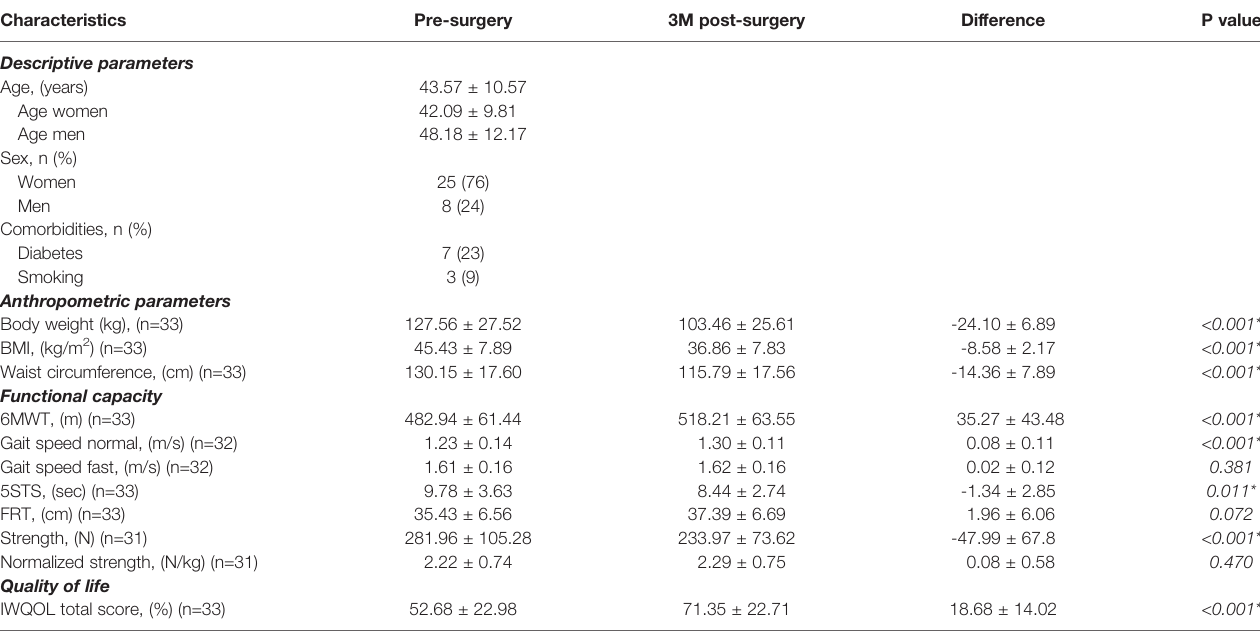
TABLE 2 | Changes in anthropometric parameters, functional capacity, and quality of life pre- to post-surgery (n = 33). Characteristics